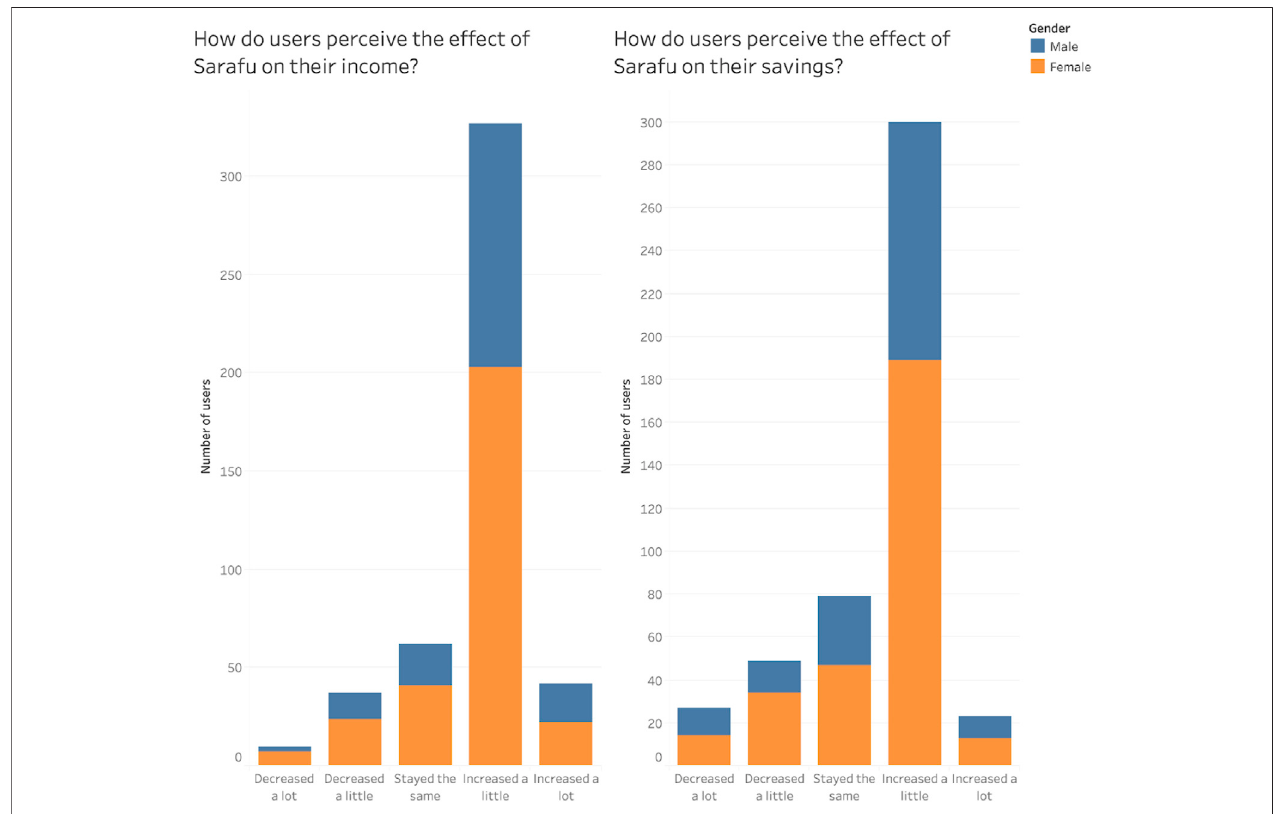
FIGURE 2 | Perceptions of the effect of Sarafu on income and savings (Kenya Red Cross, 2020).